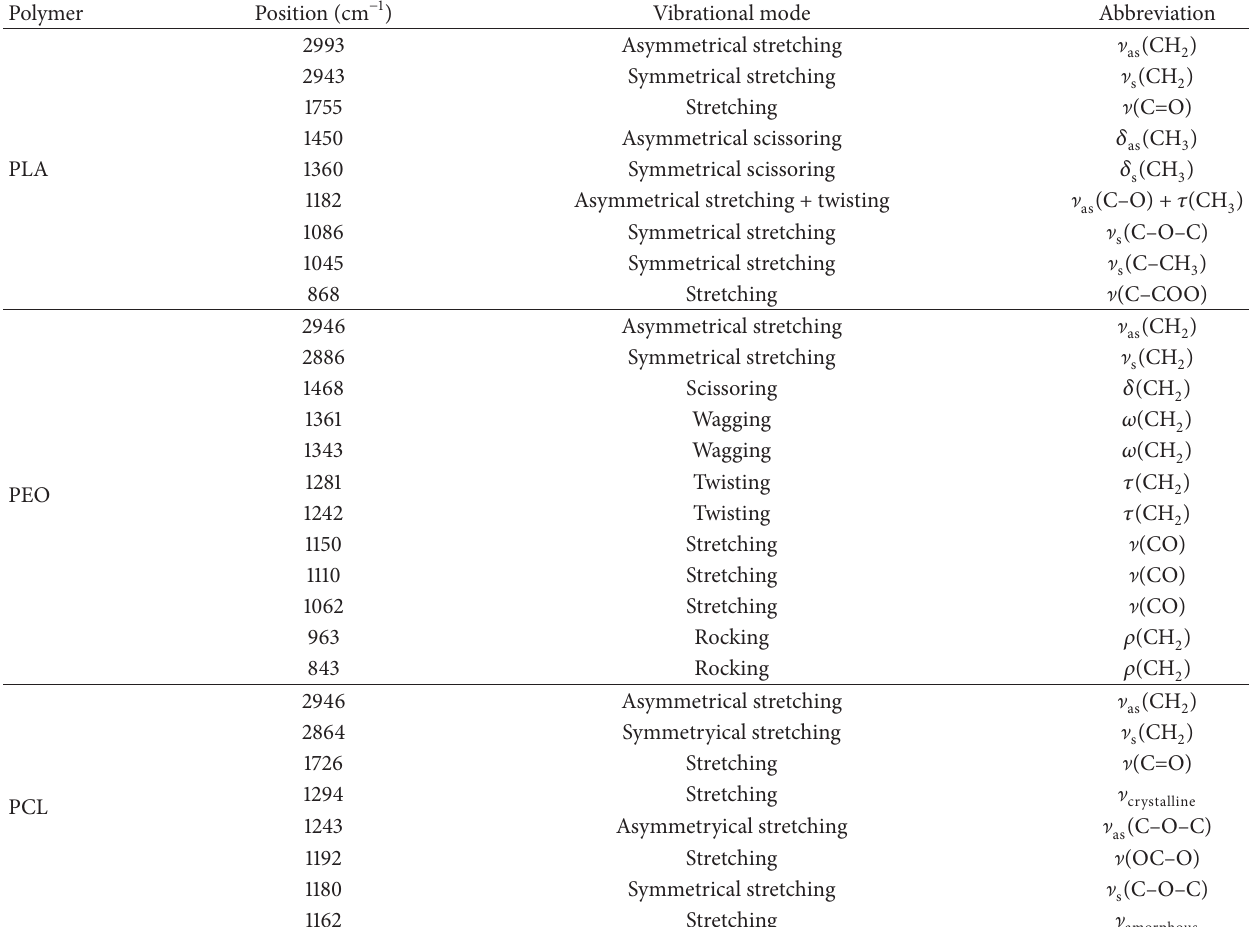
Table 4: Characteristic infrared bands of PLA, PEO, and